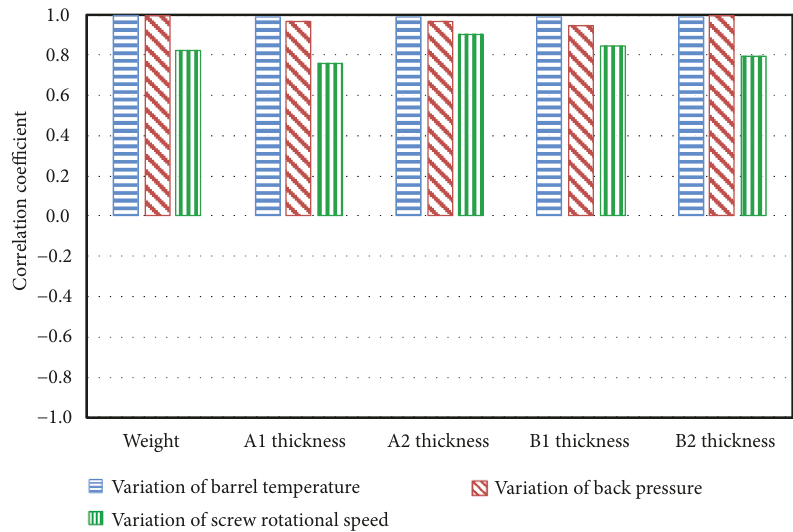
Figure 15: Correlation between clamping force increment index and molded part quality measures for various plasticizing parameters. Table 11: Process parameter settings for varied V/P switchover position experiments. Fixed parameters Packing pressure